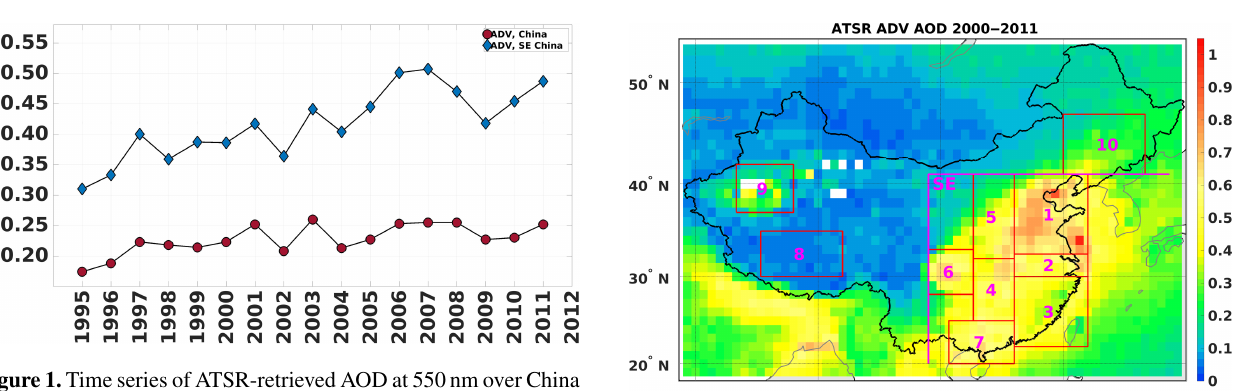
Figure 1. Time series of ATSR-retrieved AOD at 550nm over China for the years 1995–2011. Note that data are missing at the beginning of the ATSR-2 observation period in 1995 and 1996, and AATSR data start from August 2002.